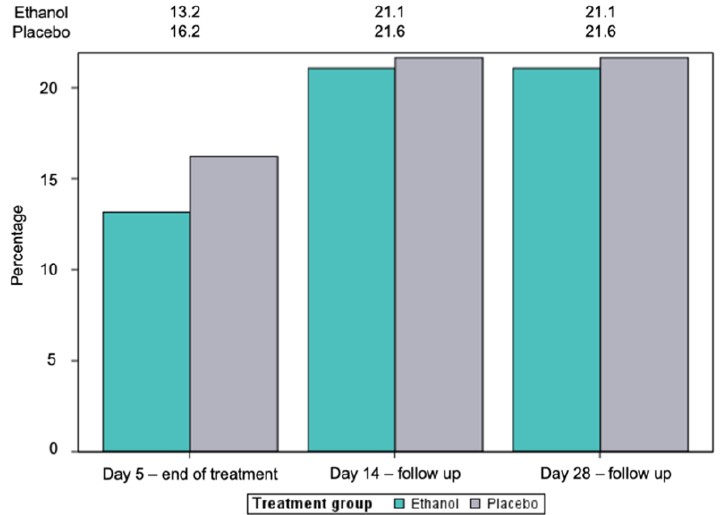
Figure 3. Cumulative relative frequency (%) of patients in both treatment groups who progress according to the modified WHO Clinical Progression Scale. Percentages were calculated based on the populations of each group (n = 38 in ethanol group and n = 37 in placebo group).